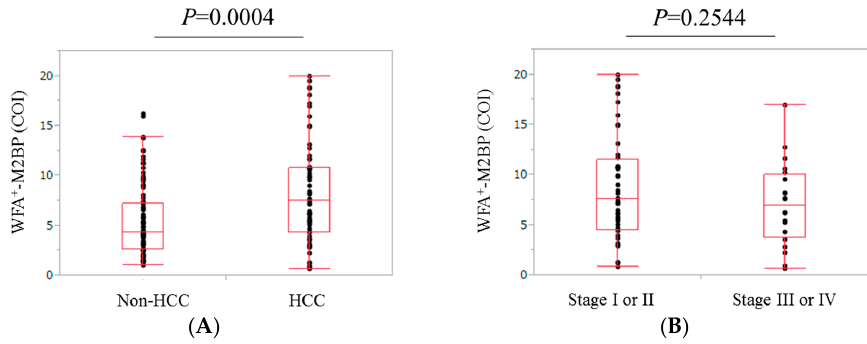
Figure 3. ( A ) Comparison of WFA + -M2BP level in patients with and without HCC ( p = 0.0004); ( B ) Comparison of WFA + -M2BP level in patients with stage I or II HCC and stage III or IV HCC ( p = 0.2554).